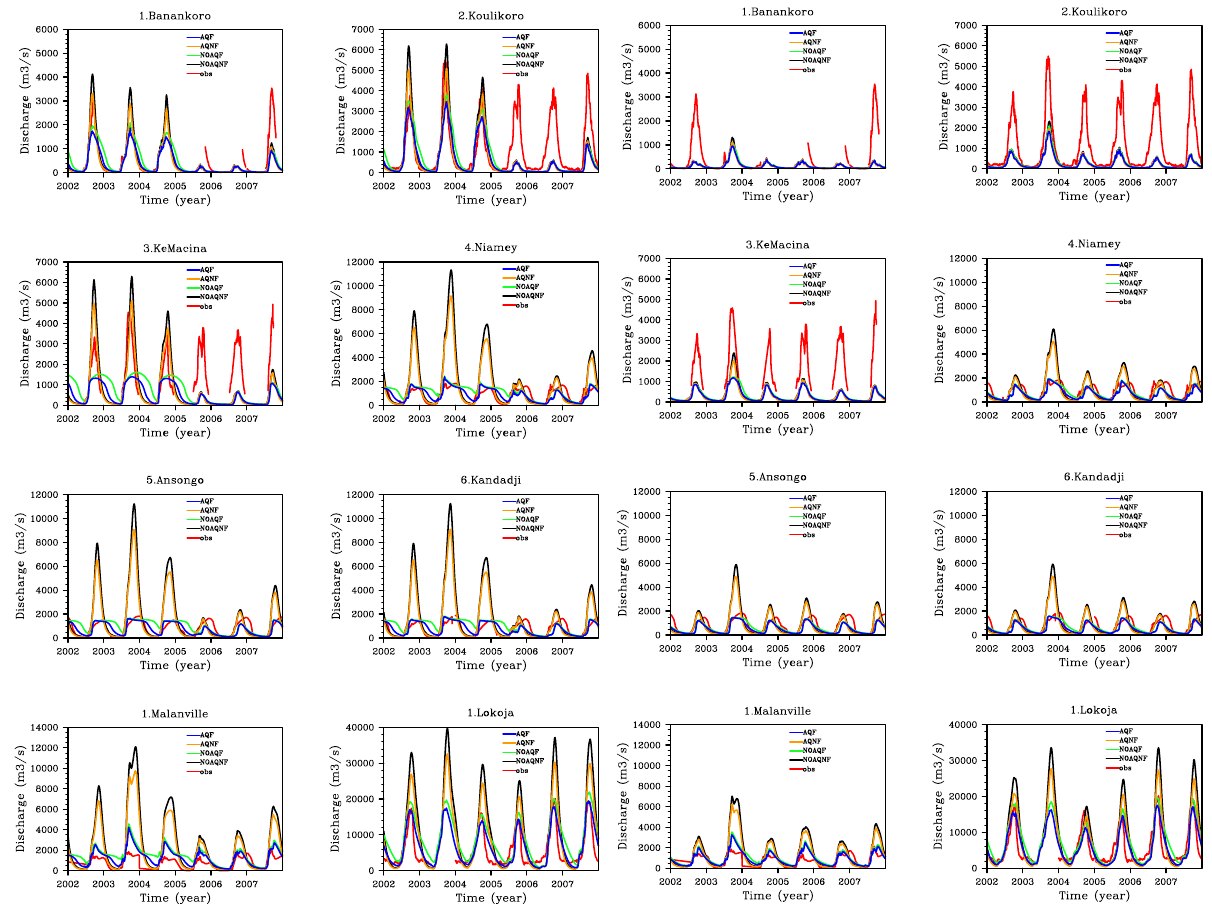
Fig. 5. Daily discharges (2002–2007) simulated by ISBA-TRIP in the 4 different configurations of the model. Observations are in red. The TRMM-3B42 (2 left columns) and RFEH (2 right columns) rain product are respectively used as forcing